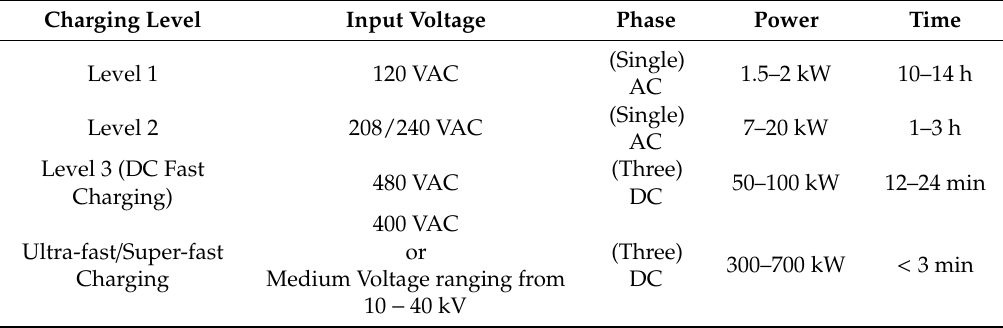
Table 1. Electrical vehicle (EV) charging stations’ electrical